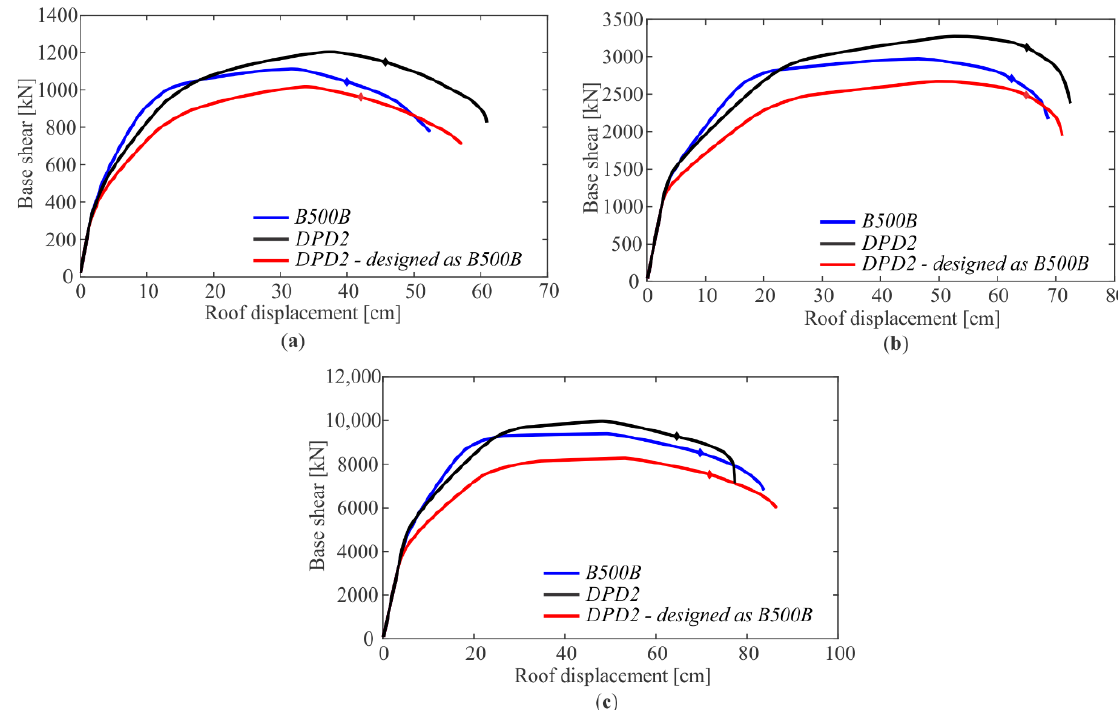
Figure 11. Pushover curves of variants of ( a ) 4-, ( b ) 8- and ( c ) 11-storey buildings. Diamond-shaped points on each of the pushover curves correspond to near-collapse displacement.